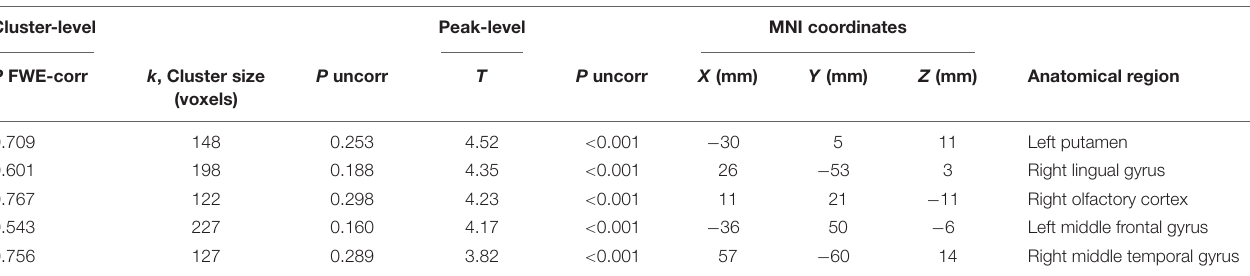
TABLE 3 | Voxel-based morphometry (VBM)